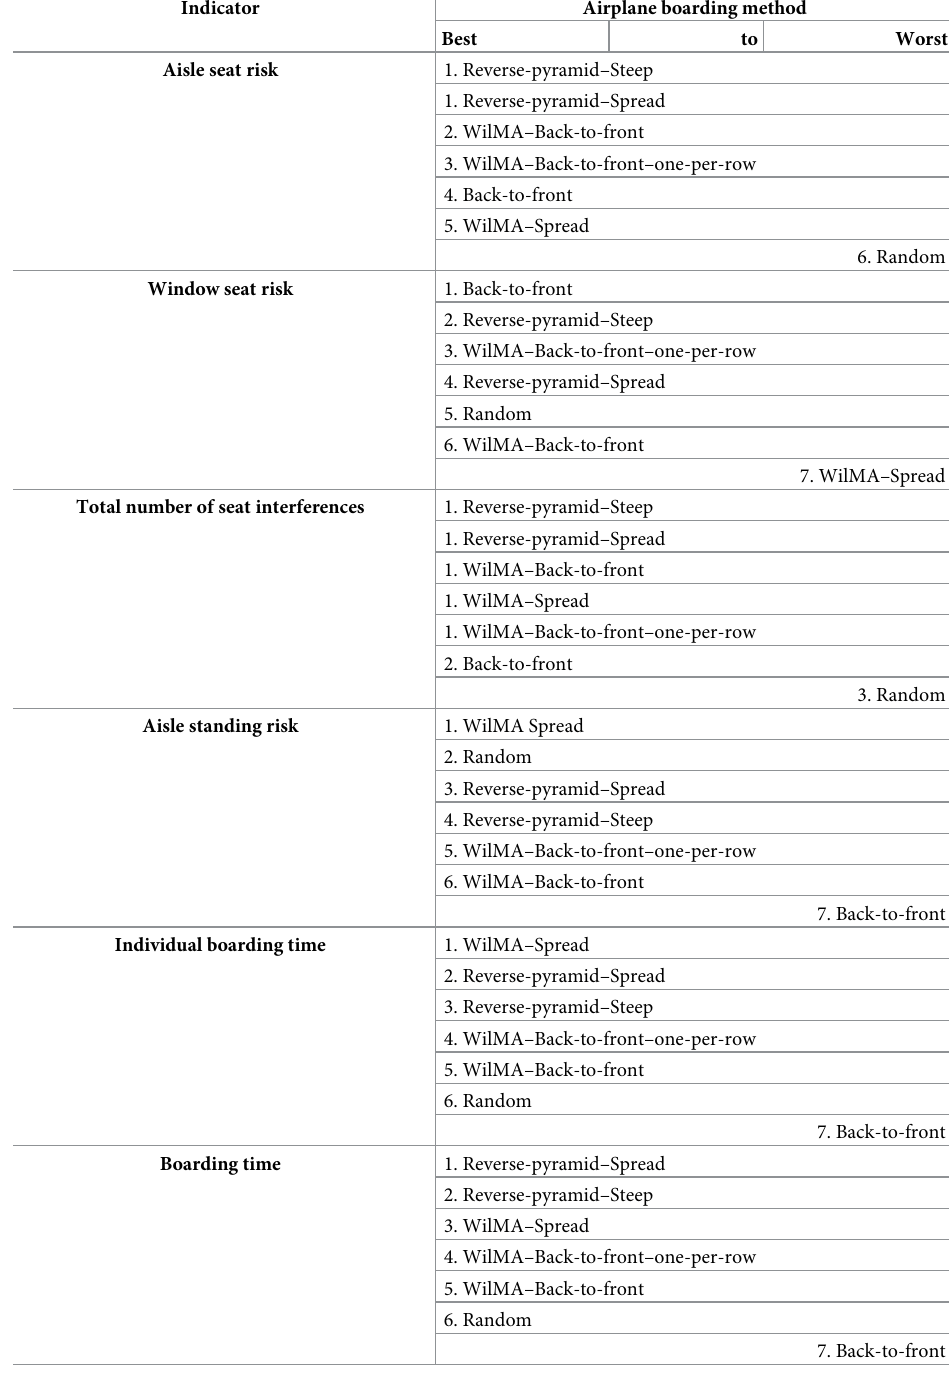
Table 9. Airplane boarding methods comparison based on the performance